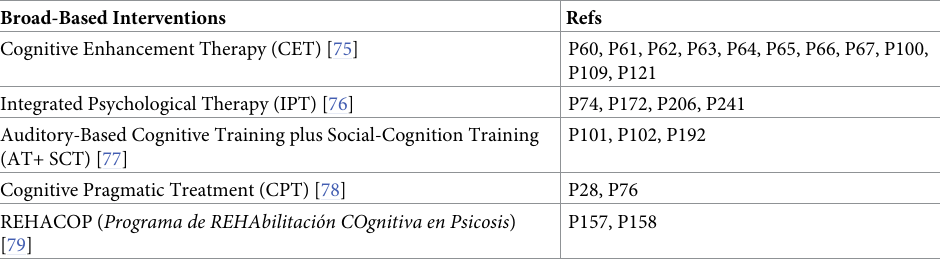
Table 5. Broad-based interventions in social cognitive remediation.